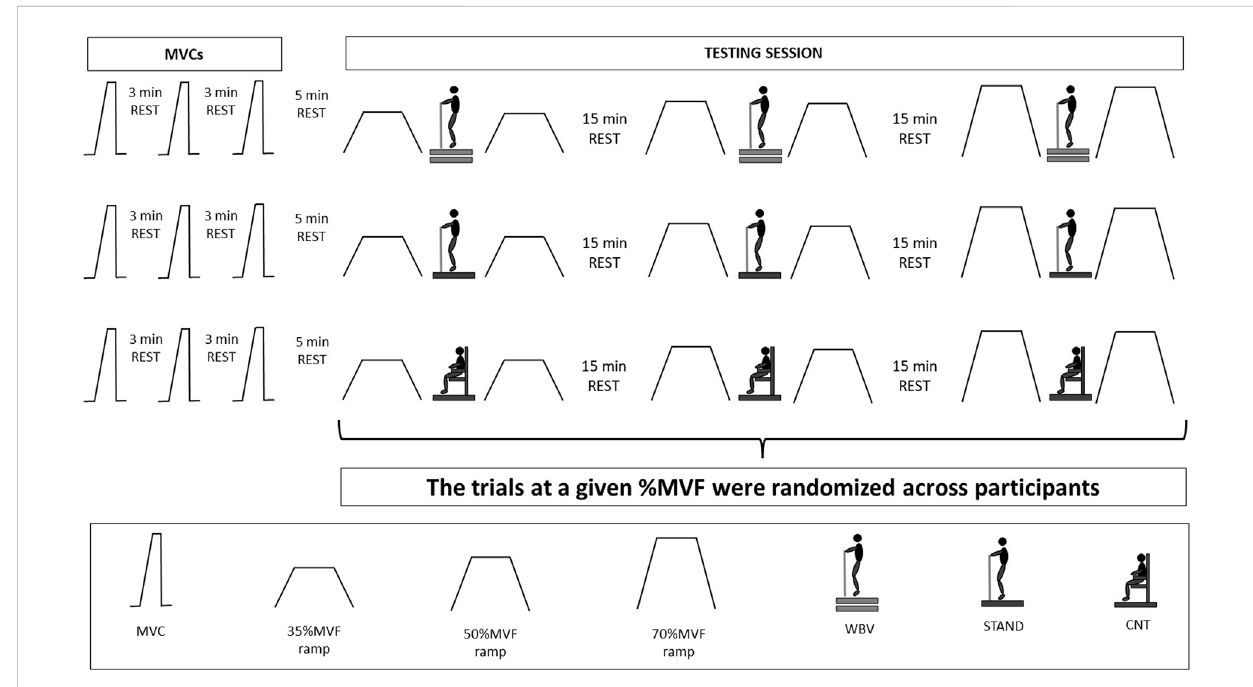
FIGURE 2 Experimental setup. Schematization of the experimental protocol. During each experimental session, participants performed three MVCs and three pre-post-trapezoidal contractions at each force target (35-50-70%MVF).